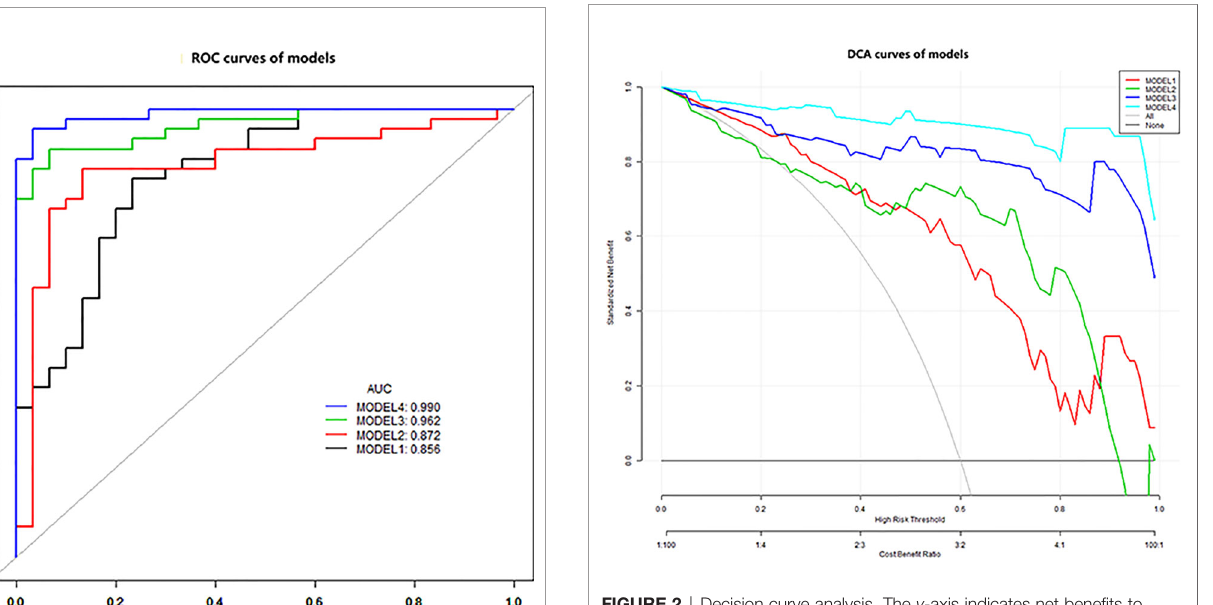
FIGURE 2 | Decision curve analysis. The y -axis indicates net bene fi ts to patients. The colorful lines represent the models, the gray line represents the hypothesis that all patients had breast cancer, and the black horizontal line represents the hypothesis that no patients had breast cancer. As showed in the curve, the net bene fi t of model 4 was better than that of the other models between threshold probabilities of 0% and